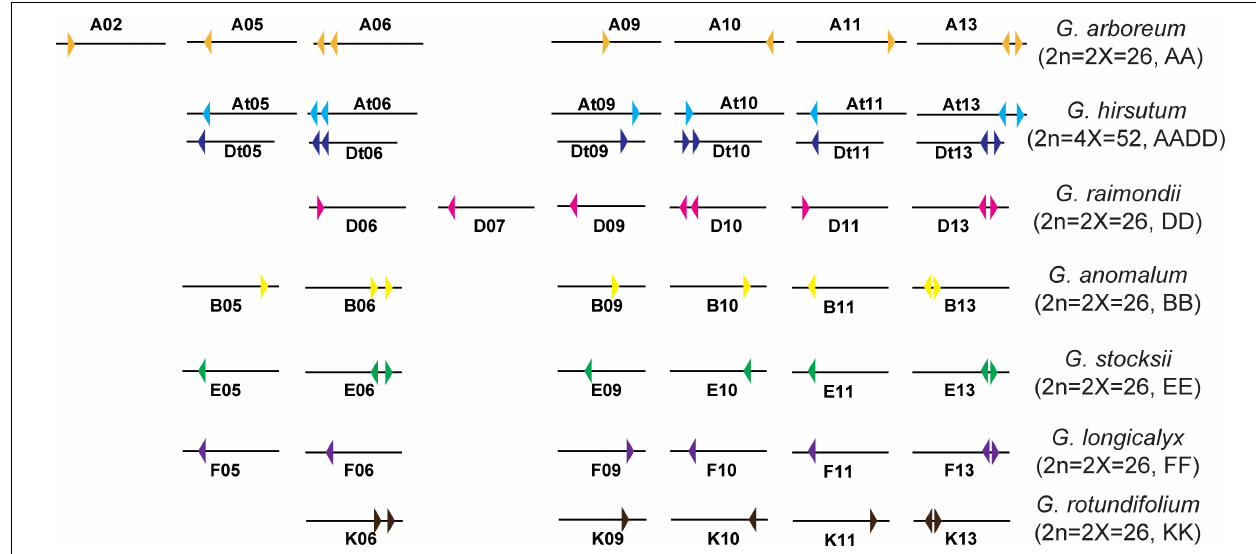
FIGURE 2 | Chromosome distribution diagram of HXK genes in G. hirsutum L., G. arboreum , and G. raimondii . Colorful triangles represent the HXK genes and their transcription direction.